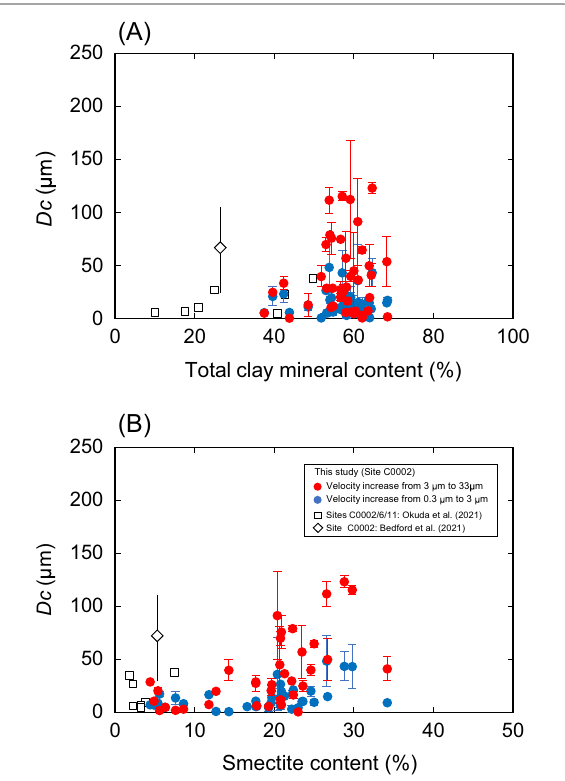
Fig. 9 Relationship between a b and A total clay mineral content Fig. 10 Relationship between D c and A total clay mineral content − and B smectite content. Red and blue circles indicate the results and B smectite content. Red and blue circles indicate the results for velocity change from 3 to 33 μm/s and from 0.3 to 3 μm/s, for velocity change from 3 to 33 μm/s and from 0.3 to 3 μm/s, respectively. Open circles, squares, and diamond indicate data from respectively. Open squares and diamond indicate data from previous previous studies of the Nankai samples along the Kumano transect studies of the Nankai samples along the Kumano transect (Okuda (Takahashi et al. 2014; Okuda et al. 2021; Bedford et al. 2021) et al. 2021; Bedford et al.